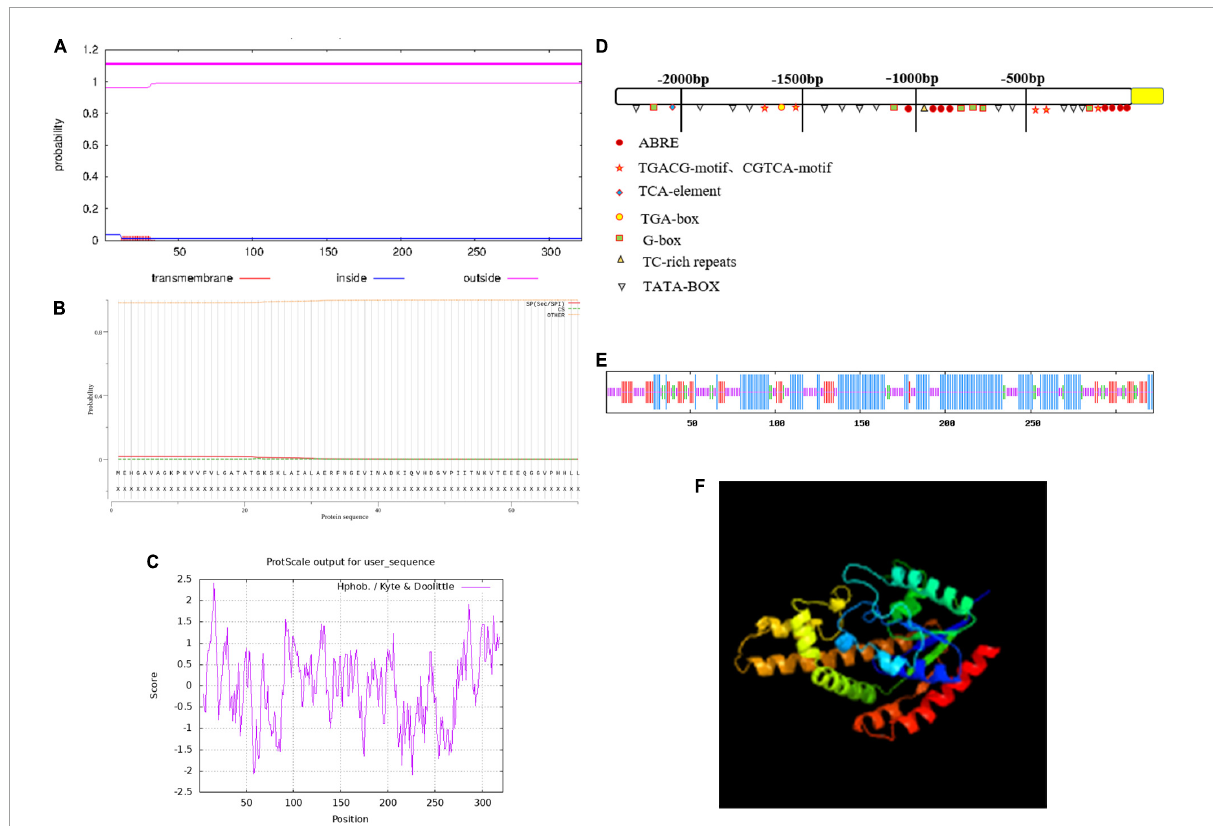
FIGURE1 The characterization of the ZmIPT2 protein. (A) Transmembrane domain prediction of ZmIPT2. (B) Prediction of signal peptide and splice siteS. (C) Hydrophobicity analysis of ZmIPT2 coding protein. (D) Analysis of flanking sequence of ZmIPT2 gene. (E) Secondary structure analysis of the ZmIPT2. The helix (h), extended strand (e), coil(c), and turn (t) are indicated in different color as blue, red, yellow, and green, respectively. (F) 3-D structure model of